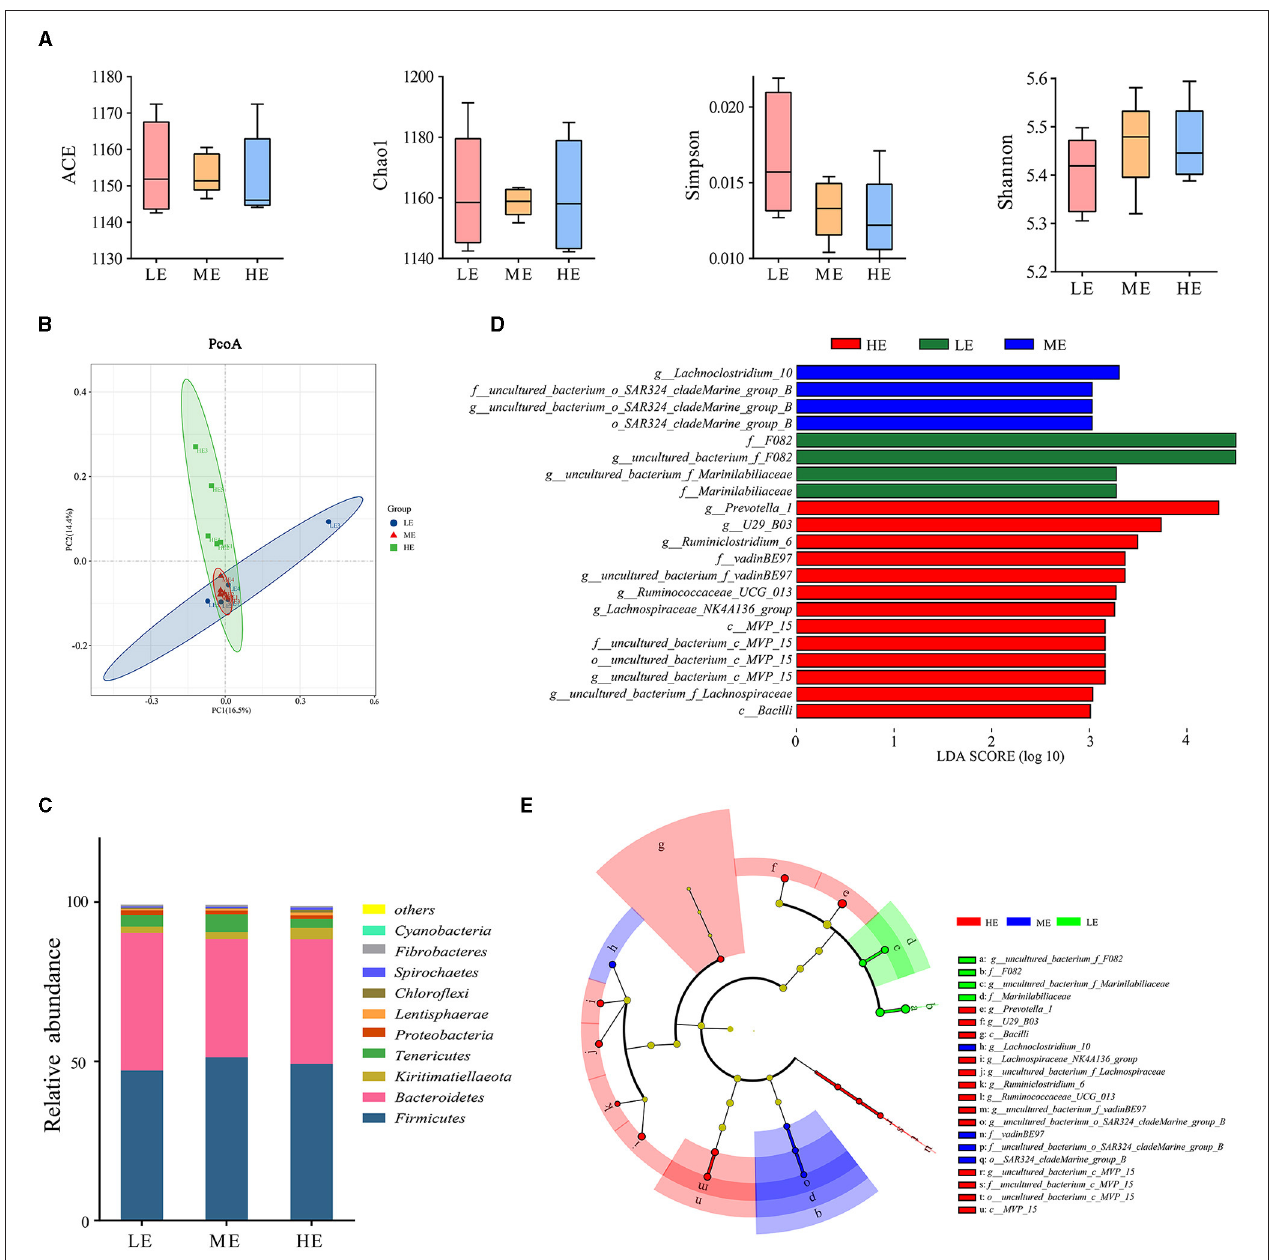
FIGURE 1 | Effect of dietary energy level on the diversity and structure of ruminal bacteria. (A) Differences in yak ruminal bacterial diversity and richness between the LE, ME, and HE groups. Box plot showing the alpha diversity of the rumen bacterial communities in yaks given different dietary energy levels. (B) Principal-coordinate analysis (PCoA) of bacterial communities based on OTUs. (C) Effects of dietary energy levels on the yak rumen bacterial composition at the phylum level. Each bar and color represent the average relative abundance of each phylum, and the 10 most abundant taxa are shown. (D) Linear Discriminant Analysis Effect Size (LEfSe). Histogram of the LDA scores for differentially abundant genera among the HE, ME, and LE groups (LDA score ≥ 3). (E) A cladogram showing the differences in the relative abundance of the taxa at five levels between the HE, ME, and LE